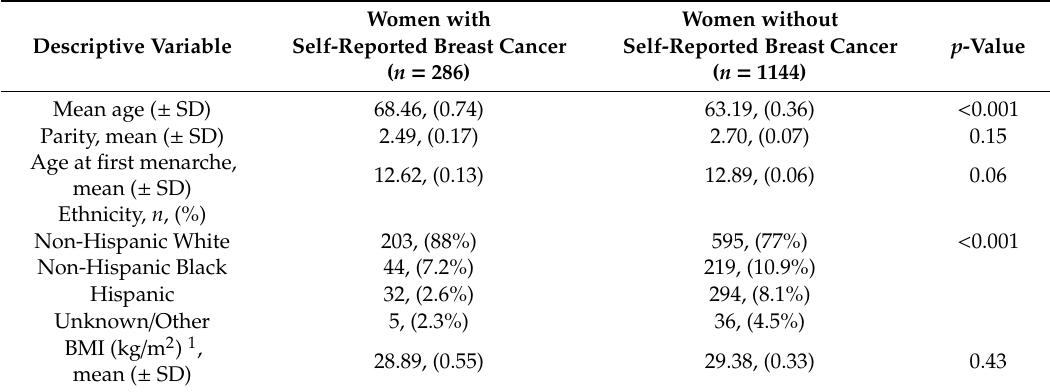
Table 1. Descriptive and other characteristics in participants with and without self-reported breast